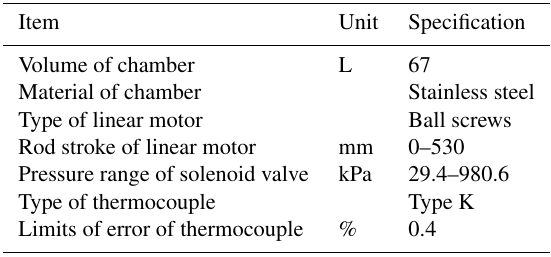
Table 1. Specifications of experimental equipment.